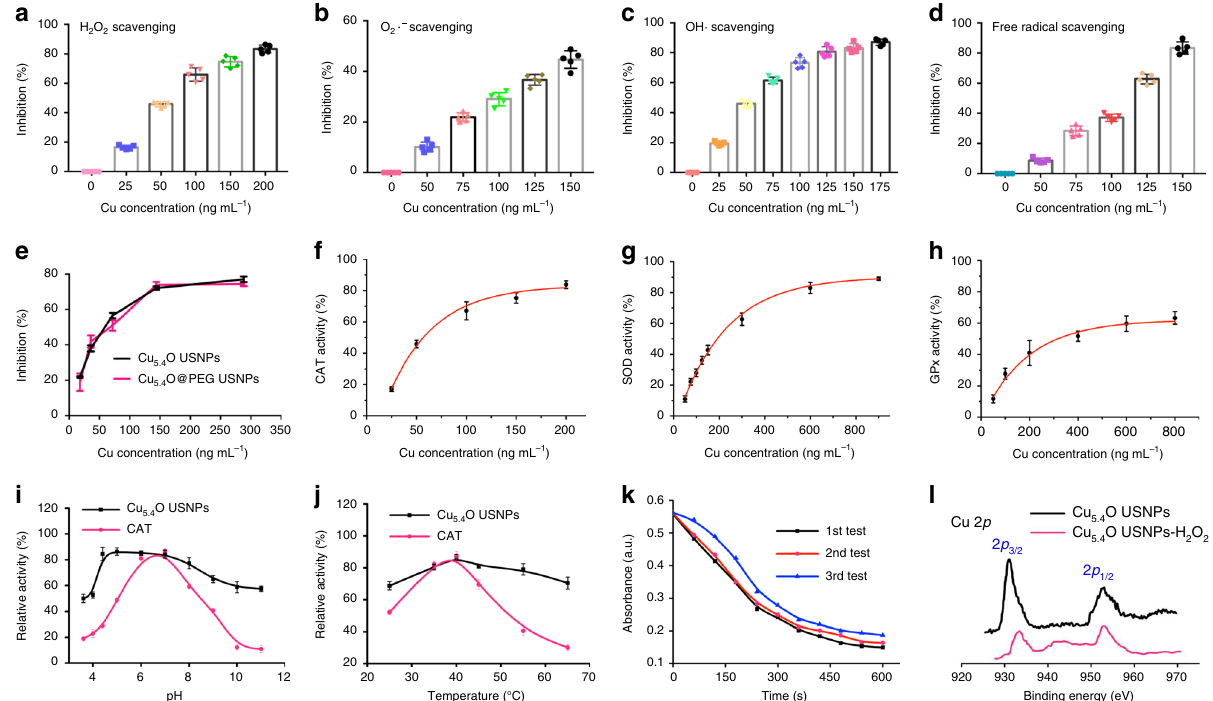
Fig. 3 ROS scavenging and multienzyme-like antioxidative activity of Cu 5.4 O USNPs. a H 2 O 2 , b O 2 − , c OH·, and d free radical scavenging ability of Cu 5.4 O USNPs. e H 2 O 2 -scavenging capacities of Cu 5.4 O USNPs and Cu 5.4 O@PEG USNPs. f CAT-like, g SOD-like, and h GPx-like activity of Cu 5.4 O USNPs. i , j The CAT-like activity of the Cu 5.4 O USNPs after different treatments. H 2 O 2 (2 mM) elimination ef fi ciencies of Cu 5.4 O USNPs (250 ng mL − 1 ) and natural CAT (40 U mL − 1 ), respectively, pretreated with different i temperature and j pH conditions. k Stability test of Cu 5.4 O USNPs (250 ng mL − 1 ) when used as CAT-like catalyst at different cycles. The concentration of H 2 O 2 is 2 mM. l XPS analysis of Cu 5.4 O USNPs before and after treatment with H 2 O 2 . In a – j , data represent means± s.d. from fi ve ( a – d ) or three (e – j ) independent replicates. Source data are provided as a Source Data fi